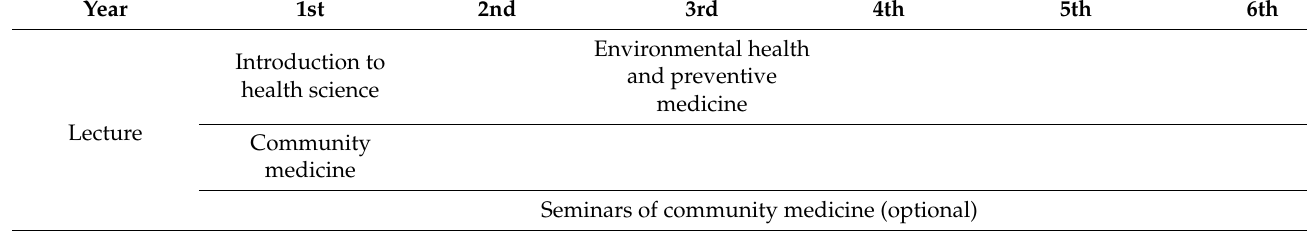
Table 1. The six-year general medicine curriculum of Shimane University Faculty of Medicine as of 2019.